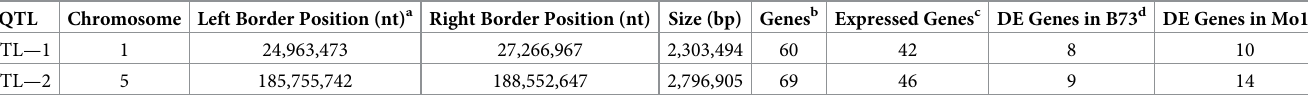
Table 4. Physical Position and Gene Composition of Identified